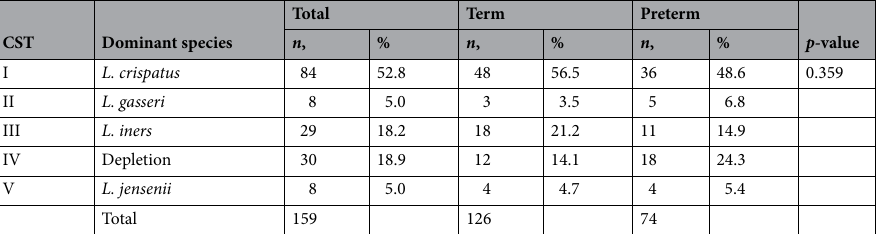
Table 4. Analysis based on CST groups (I, II, III, and V) representing the dominant Lactobacillus species in women sampled at different weeks of gestation (n = 159). Statistical analysis was performed by Fisher’s exact test. CST Community state type.